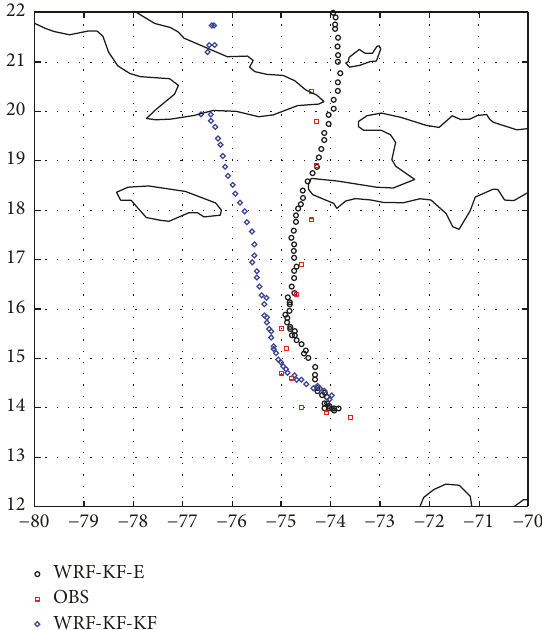
Figure 8: Comparison between the observed Matthew Hurricane best track (2 October–5 October 2016, 6-hourly step) and the predicted ones by KF-E-IFS and KF-KF-IFS WRF simulations (at 5 km, hourly step).